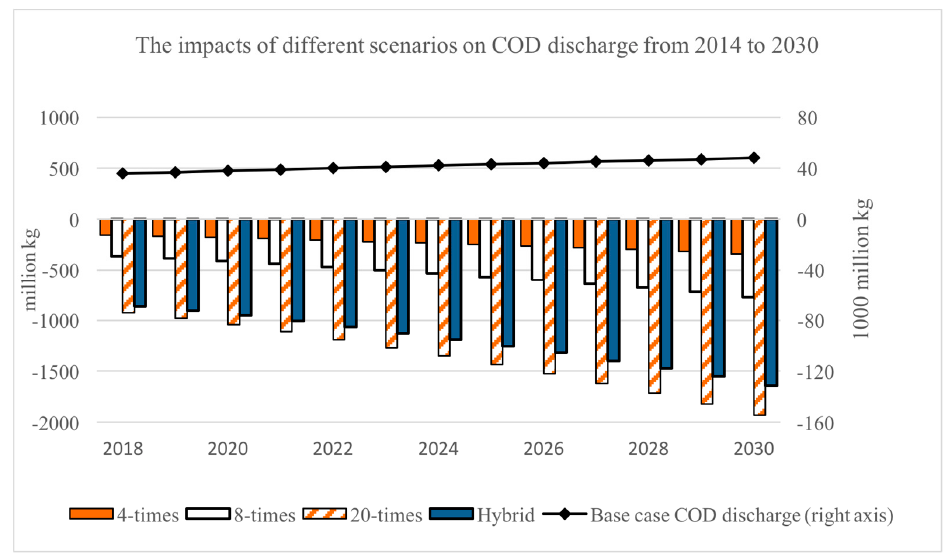
Figure 4. The impacts of different scenarios on COD discharge from 2018 to 2030. Negative values in the discharge change (left axis) mean that the total COD discharge is less than the total discharge in baseline (black line, right axis).